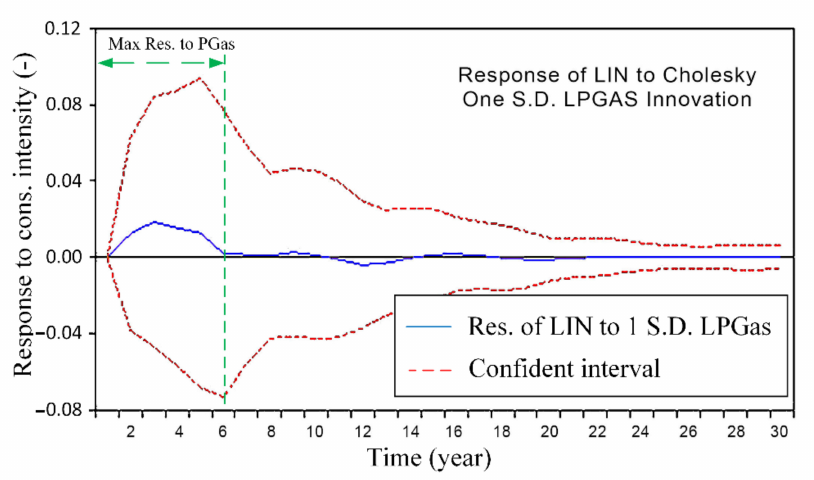
Figure 3. The estimated effect of a gas price impulse on the rate of a standard deviation due to the energy consumption intensity, between